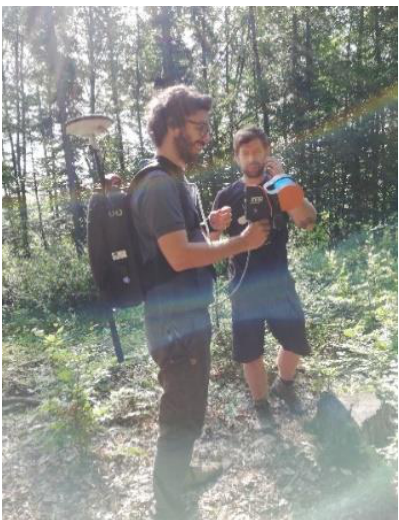
Figure 2. GeoSLAM ZEB Horizon and IMU backpack SPAN NovAtel during data collection.